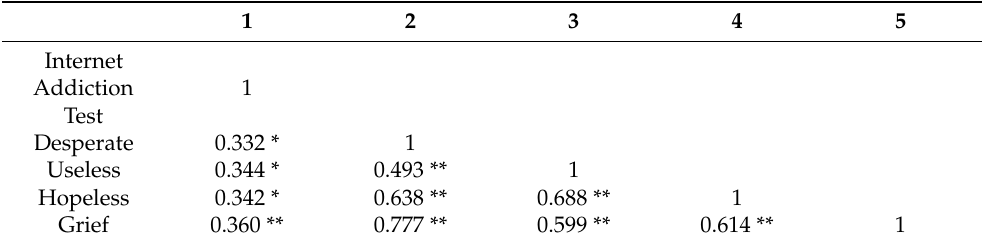
Table 2. Association between Internet dependency and the dysfunctional negative emotions desper- ate, useless, hopeless, and grief.